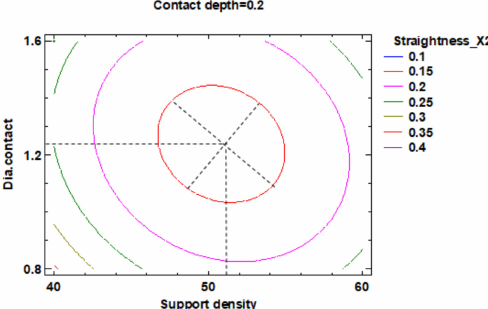
Figure 19. Contours of Estimated Response Surface for Straightness_X2 and centre contact depth.